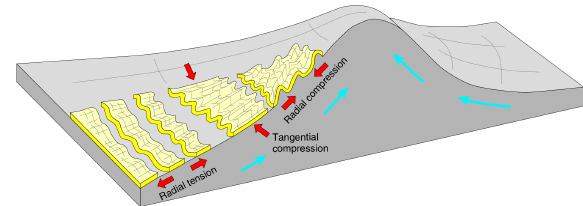
Figure 12. Schematic diagram of three-dimensional stress (red ar- rows) and associated deformation of an intrasalt competent layer (yellow) in a circular to slightly elliptical salt pillow. As salt flows from beneath the depocenters into the pillow (blue arrows), radial extension and contraction (boudinage and folds) are accompanied by constrictional folding due to convergent flow into the pillow. Drafted from original sketch by Frank J.